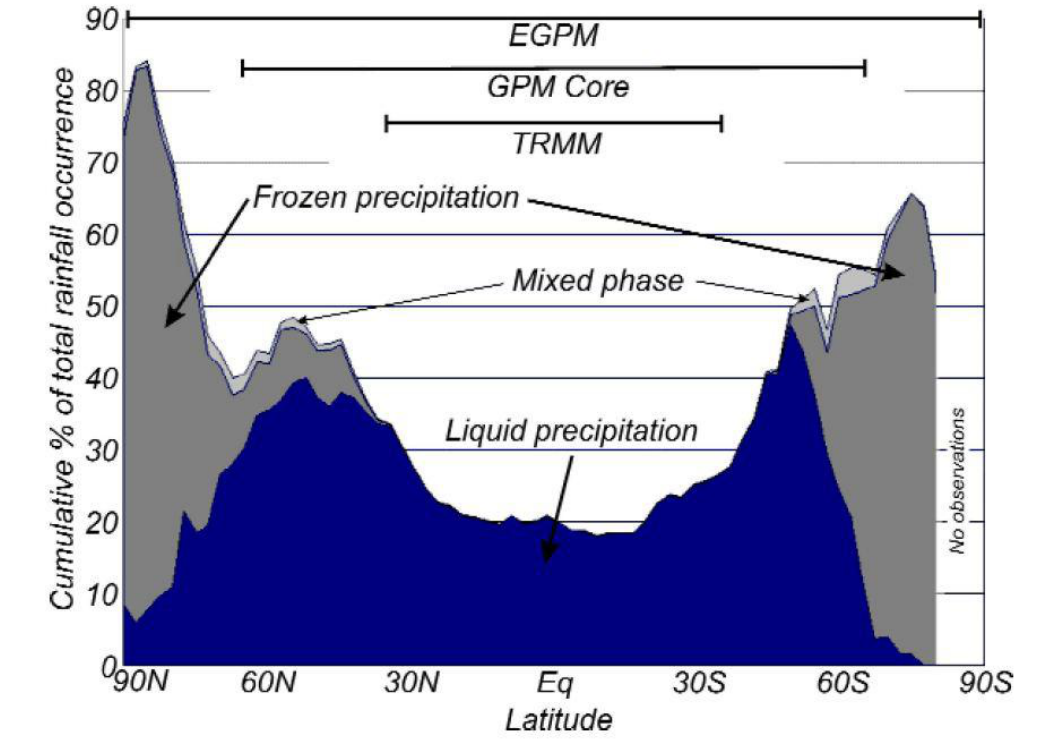
Figure 1. Mean zonal occurrence of oceanic light precipitation (as a percentage of total rainfall occurrence) derived from the Comprehensive Ocean-Atmosphere Data Set (COADS) using ship-borne meteorological observations (1958–1991). The latitude ranges on top refer to the coverage of current or proposed satellite missions: European contribution to GPM (EGPM), Global Precipitation Measurement (GPM) mission core satellite, and Tropical Rainfall Measuring Mission (TRMM). (courtesy of C. Kidd, University of Birmingham